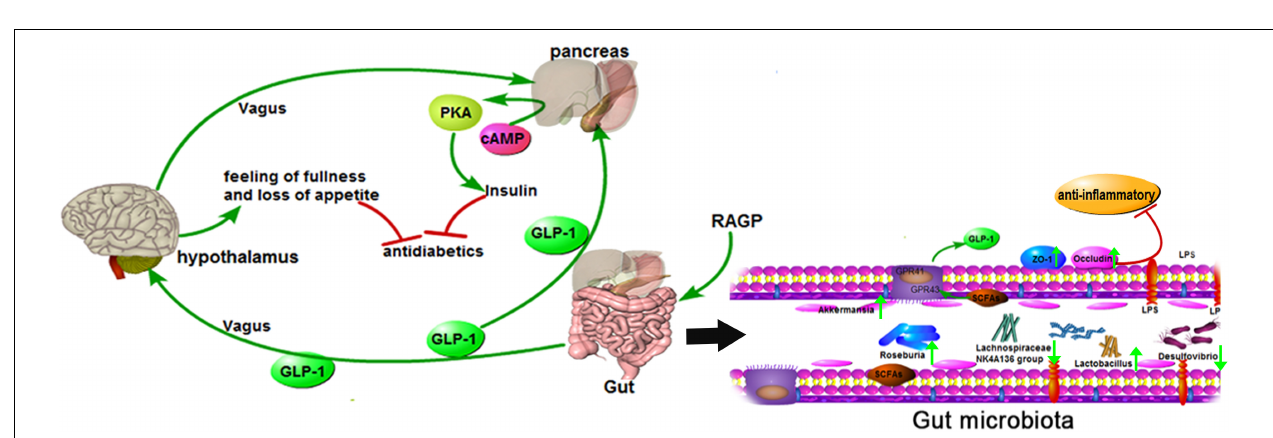
FIGURE 7 | Mechanism of RAGP against T2DM: the interaction of gut microbiota and the reduction of inflammation. RAGP regulated the structure of the gut microbiota, increased the abundance of Lactobacillus and SCFAs-producing (Roseburia and Akkermansia), and decreased Lachnospiraceae NK4A136 group and LPS-producing (Desulfovibrio). Meanwhile, RAGP up-regulated the expression level of ZO-1 and occludin, which improved intestinal integrity and suppressed the LPS-induced inflammation. The improved effect was also indicated by the green arrow after RAGP treatment.